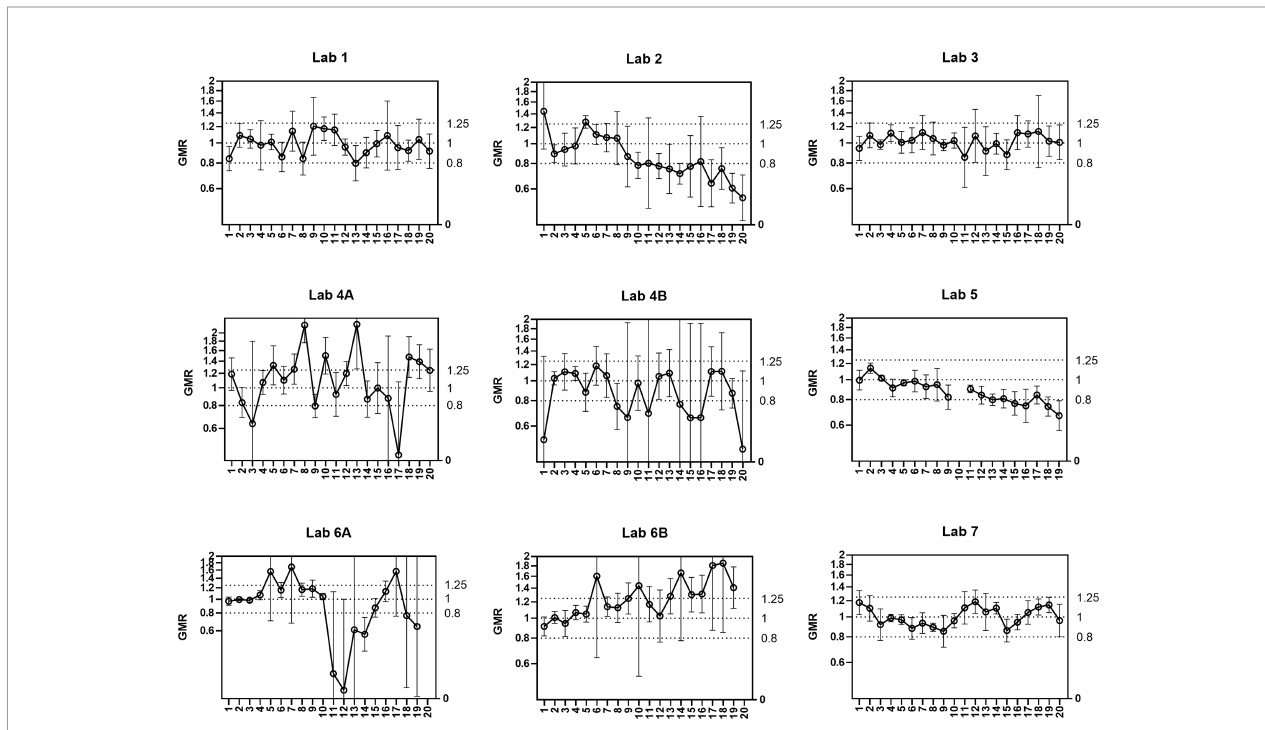
FIGURE 2 | Within-run assay performance – number of plates per run (end of run). 6 samples were tested per plate for 20 plates in a single run. Seven participating laboratories returned data (two labs returned data for 2 operators - A/B) carrying out a single run. A reference titre for each sample was calculated as the median from plates 1-5 for geometric mean ratio (GMR) calculation. The geometric mean of GMR per plate is plotted over 20 plates (error bars show 95%CI). Indicative interval of 0.8-1.25 is shown by dashed lines. After data exclusion as in material and methods Lab1 N=6, Lab 2 N=6, Lab 3 N=5, Lab 4 N=6, Lab 5 N=4, Lab 6 N=6, Lab 7 = 5.